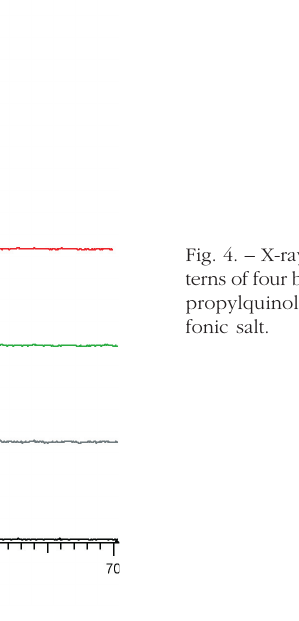
Fig. 4. – X-ray diffraction pat- terns of four batches of the 2-n- propylquinoline camphorsul- fonic